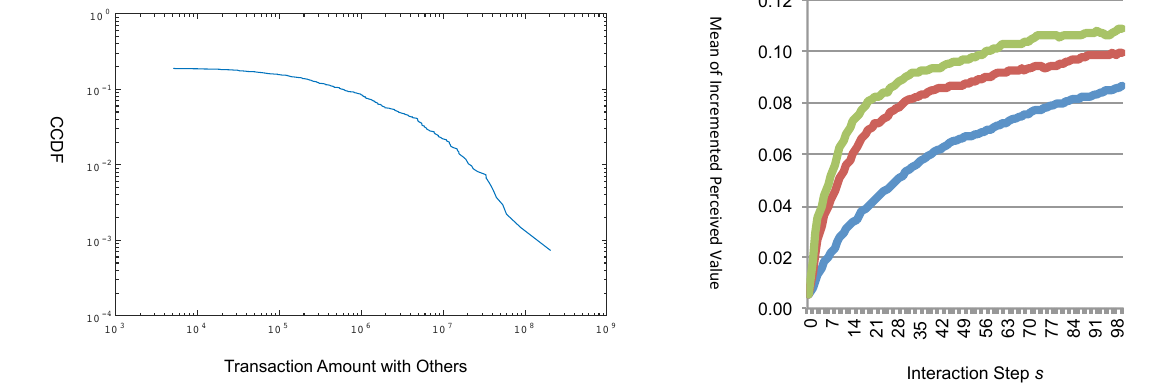
Figure 1. Distribution of Transaction Amount with Others Figure 2. Contagion of Customer-Perceived Value (Value of “Prestige” for Customers) As Figure 2 shows, the predicted increment of the value varies by not only the probability of imitation ( q ) but also the depth of interaction steps ( s ). Accordingly, the average payoffs predicted via simulation should be compared with respect to both q and s